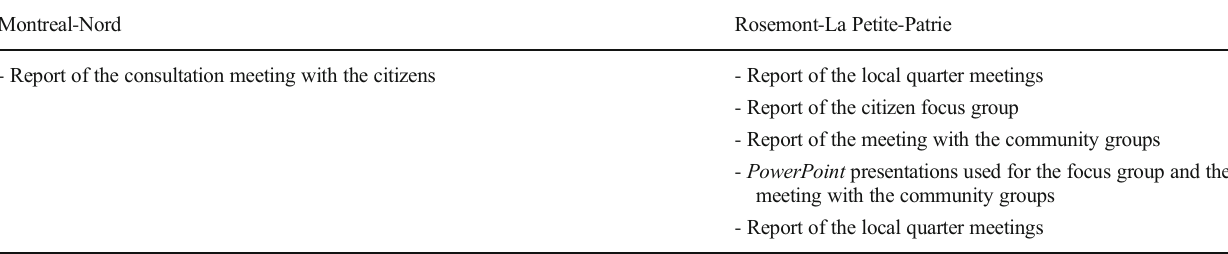
List of the documents used to analyse the outcomes of the participatory process. The documents were provided by the local planners. The reports of the local quarter meetings and the citizen focus group in Rosemont-La Petite-Patrie can be found online at www.plandedeplacementrpp.com/ Montreal-Nord